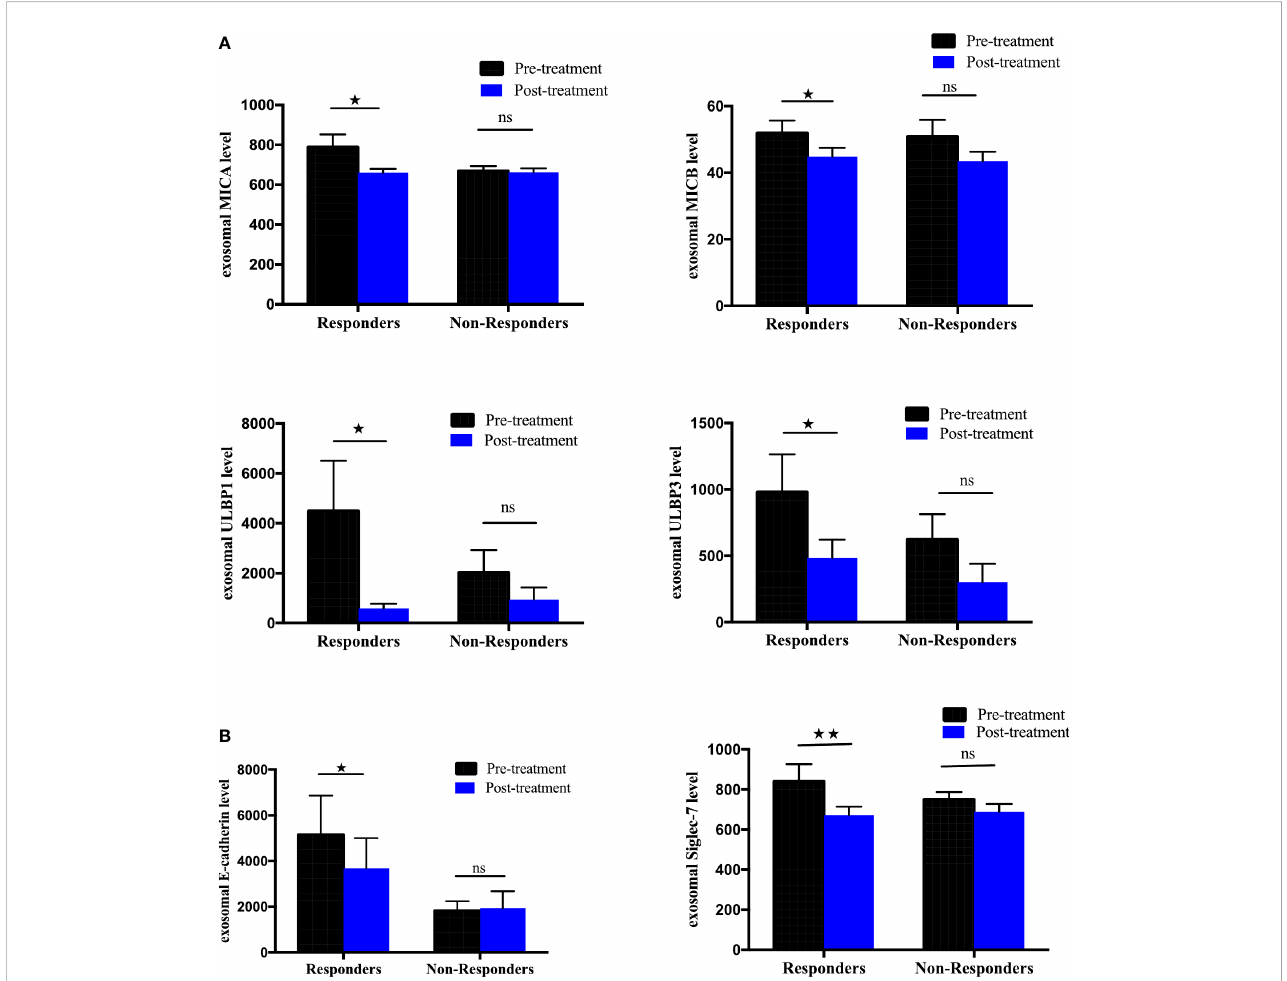
FIGURE 7 Differential expression of exosomal immune-oncology markers strati fi ed NSCLC patients according to clinical outcome. Association of change in (A) exosomal immune-stimulatory markers including MICA (p=0.0391), MICB (p=0.0469), ULBP1 (p=0.0156), ULBP3 (p=0.0391) and (B) exosomal immune-inhibitory markers including E-Cadherin (p=0.0312), Siglec-7 (p=0.0078) evaluated before and after ICI therapy in NSCLC patients grouped according to disease status (responders, n= 8; non-responders=9. Wilcoxon matched-pairs signed-rank test. P-values <0.05 were considered statistically signi fi cant. * signi fi cant; ** moderate signi fi cant; ns non-signi fi